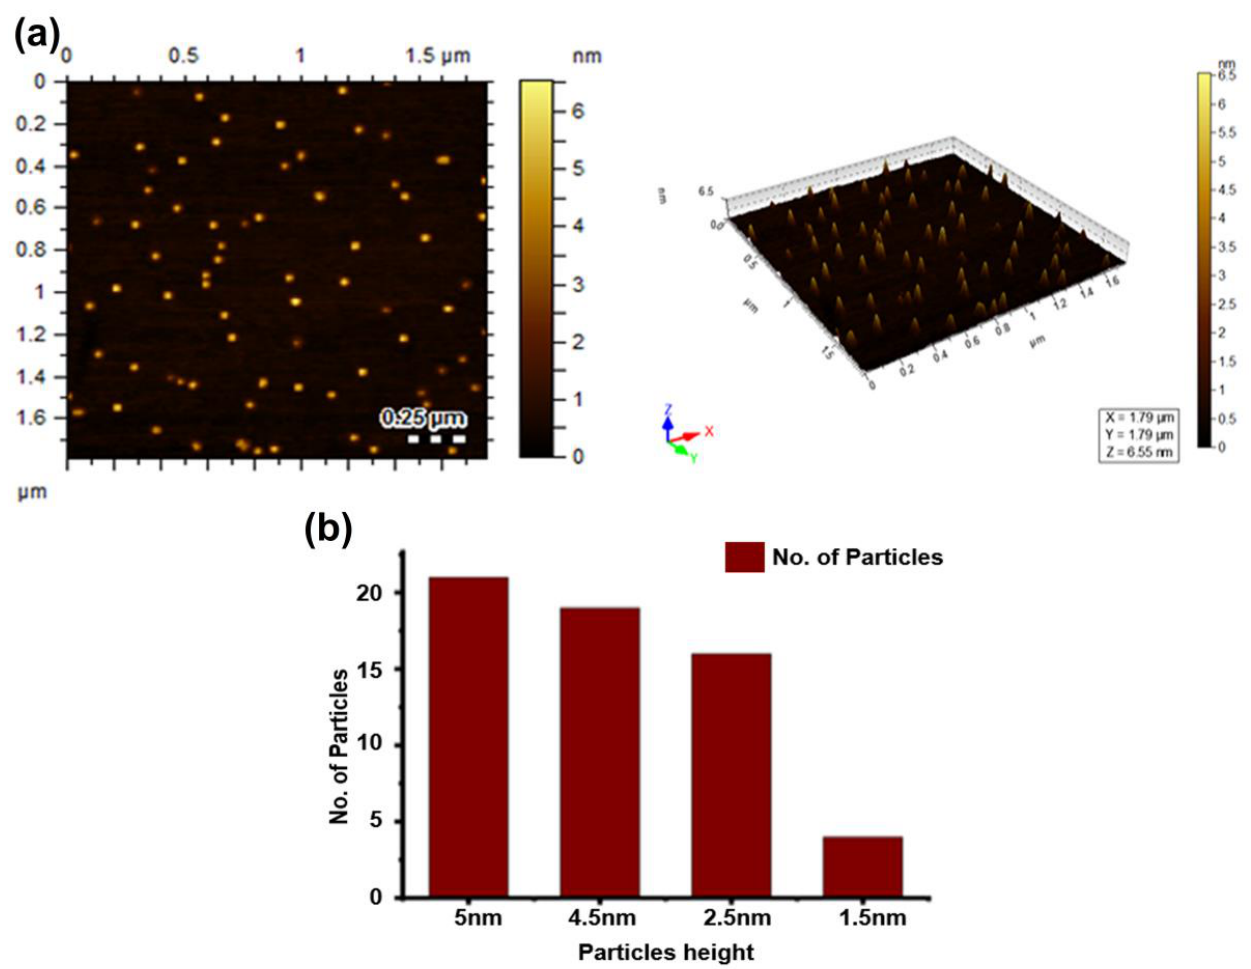
Figure 5. ( A ) AFM image of XG-AgNPs under optimized condition; ( B ) Particle size distribution